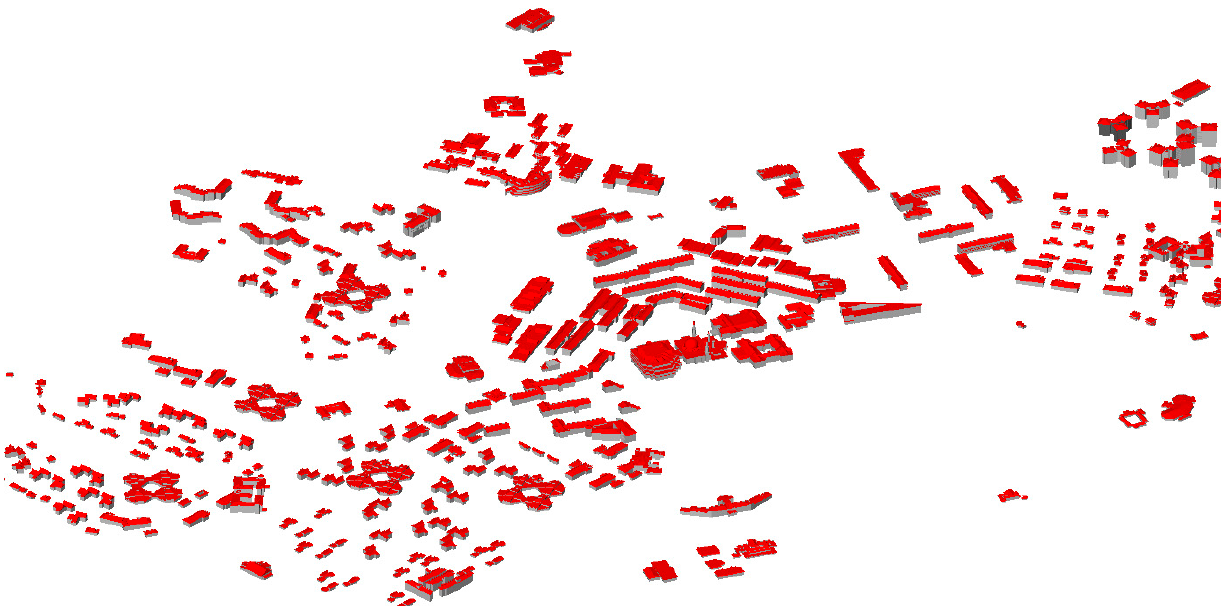
Figure 12. Virtual 3D of Universiti Teknologi Malaysia campus with 381 buildings as displayed using FZK Viewer.